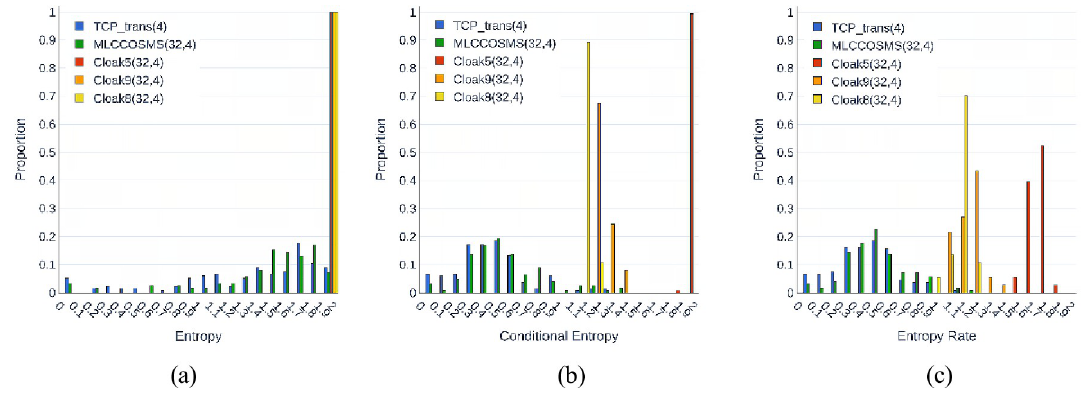
Fig 7. Histogram of different entropies of the five kinds of TSLS segments ( W p = 1000). (a) entropy histogram of λ ch . (b) conditional entropy histogram of λ . (c) entropy rate of λ ch ch